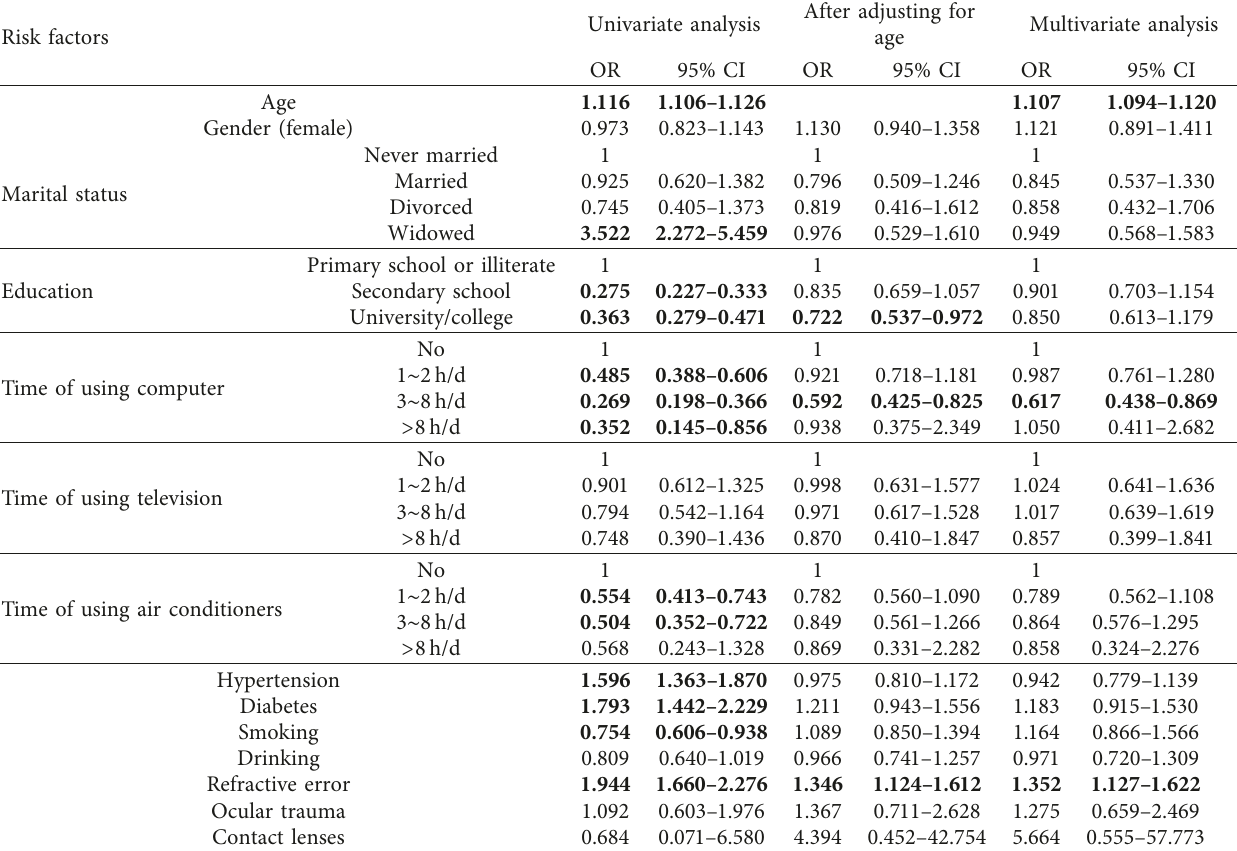
Table 4: Univariate and multivariable association analysis of risk factors for